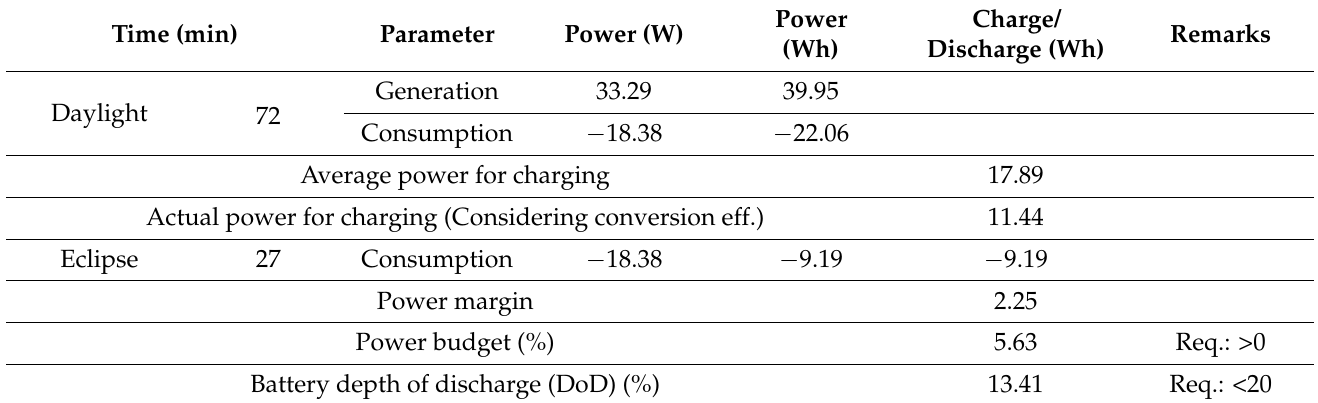
Table 2. Energy balance analysis in mission operation mode of Earth observation.